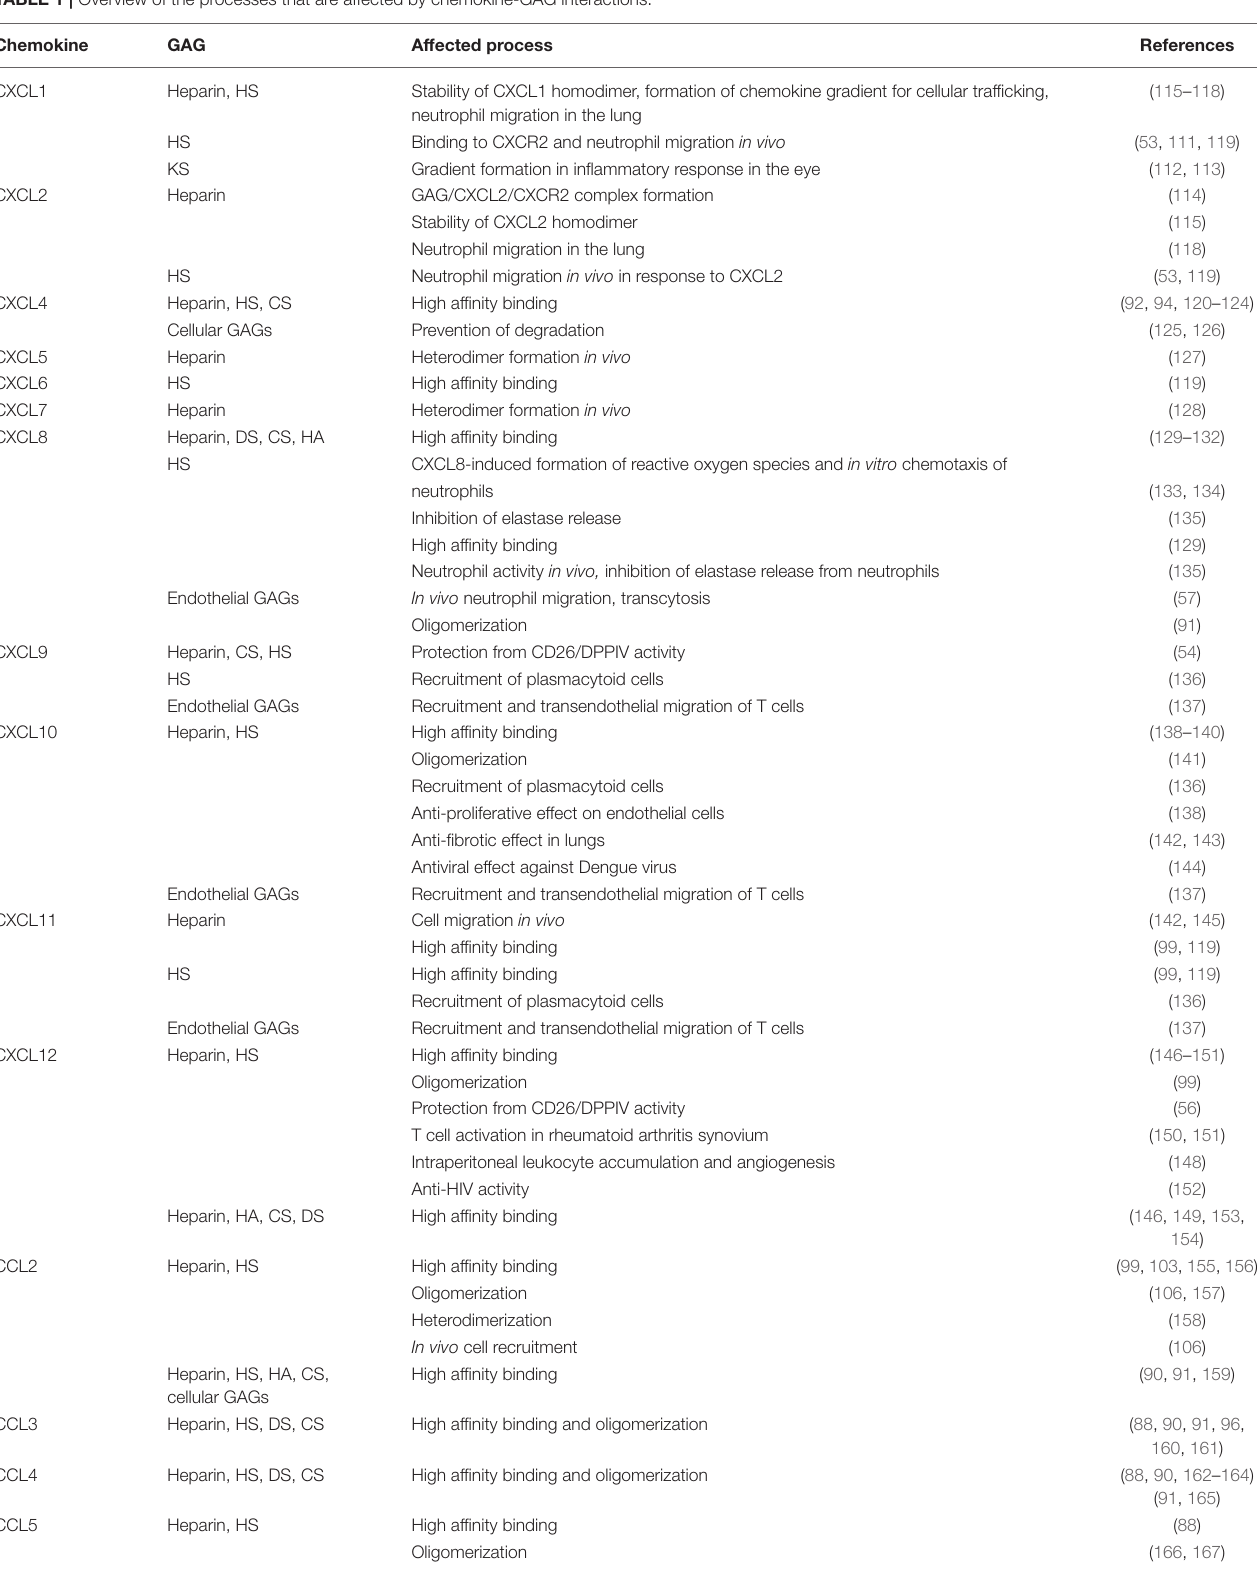
TABLE 1 | Overview of the processes that are affected by chemokine-GAG interactions.